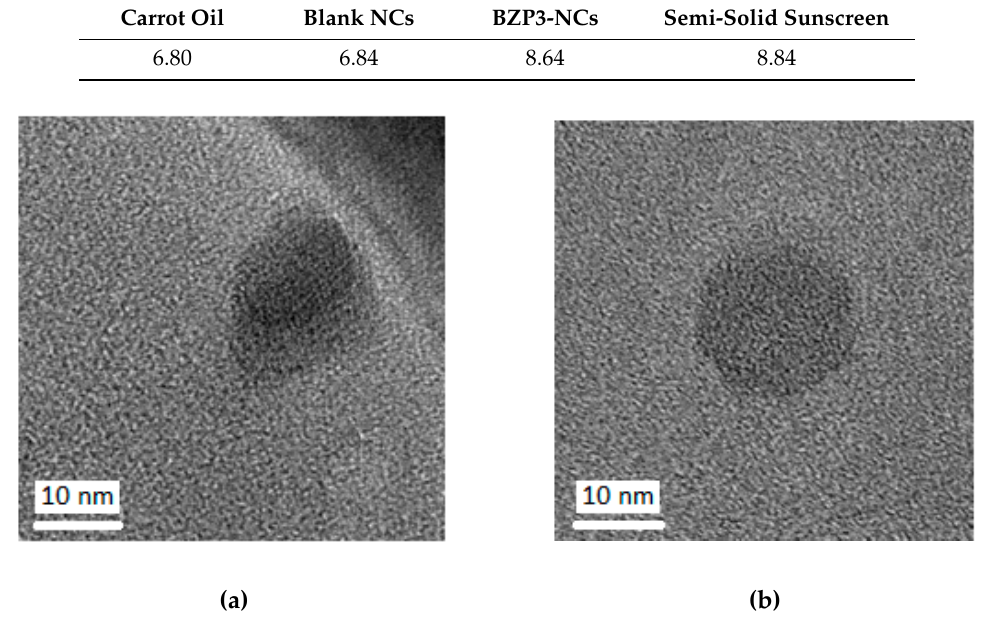
Figure 2. TEM images of ( a ) blank NCs and ( b ) BZP3-NCs.